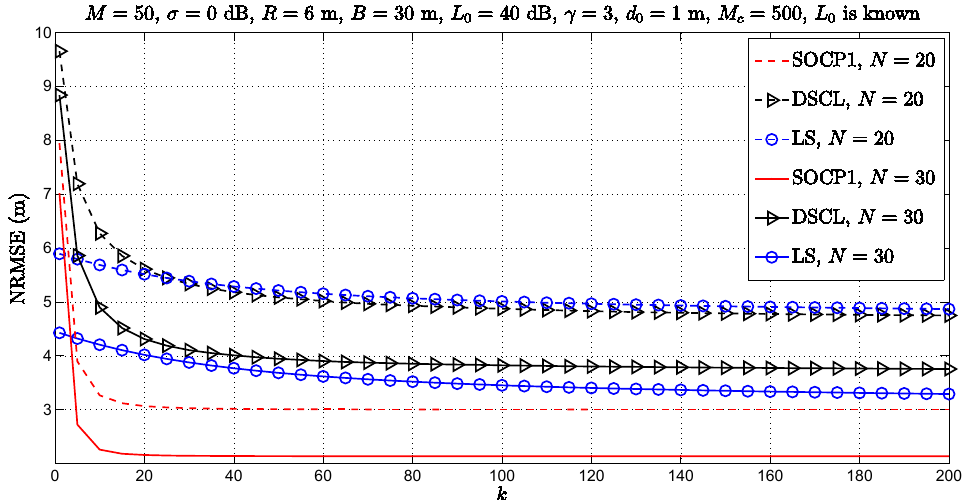
Figure 3. Simulation results for cooperative localization when L root mean square error (NRMSE) versus k comparison for different N , when M = 50 ,